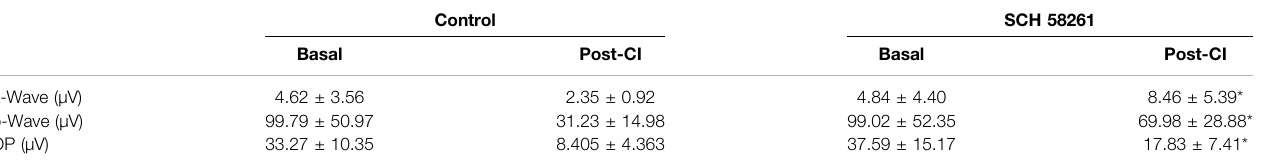
TABLE 3 | ERG recordings and oscillatory potentials of eyes treated with SCH58261 and their controls. Mean values and standard deviations are shown, Student ’ s t -test,* p < 0.05.